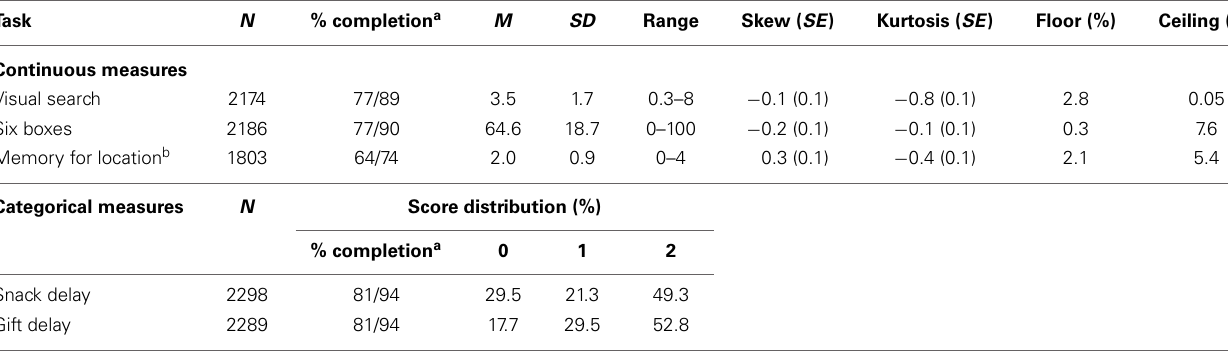
Table 1 | Descriptive statistics for executive function measures.